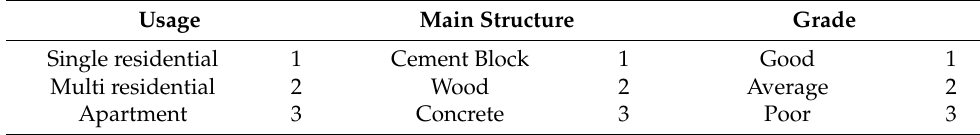
Figure 3. Durable life and standard unit cost for building unit price index. For example, as shown in Figure 3, the standard unit cost for an average-grade, sin- gle-residential, cement block residential building (classification no. 1-1-2) would be 6.92 USD/m 2 , with a durable life of 20 years. 4. Results and Discussion Zanzibar is currently experiencing rapid urbanization. Local governments need sta- ble and reliable revenue sources to meet the needs of residents and firms for local public services, and property taxation is one of the best options available for Tanzania and other African countries. However, property taxes currently fail to generate sufficient revenues